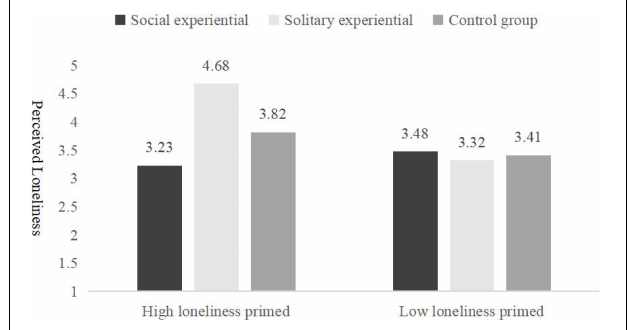
FIGURE 5 | Loneliness perception from experiential and material purchases by social nature (Experiment 3).